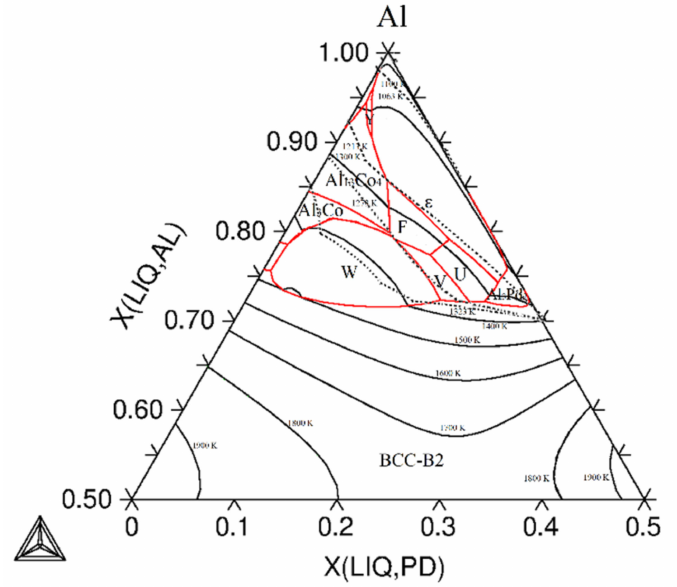
Figure 6. Calculated liquidus surface prediction of the Al–Co–Pd system. Dotted lines represent liquidus lines from isothermal sections from study [10].